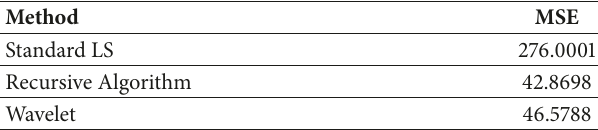
Figure 6: Evolution of cut-off frequencies: low-pass filter. Table 2: Comparison of the mean squared error (MSE).